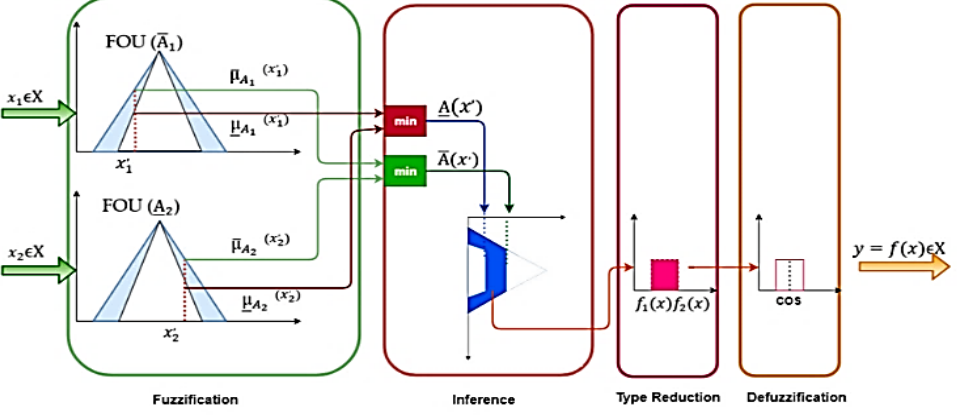
Fig. 3. Structure of a type-2 fuzzy logic